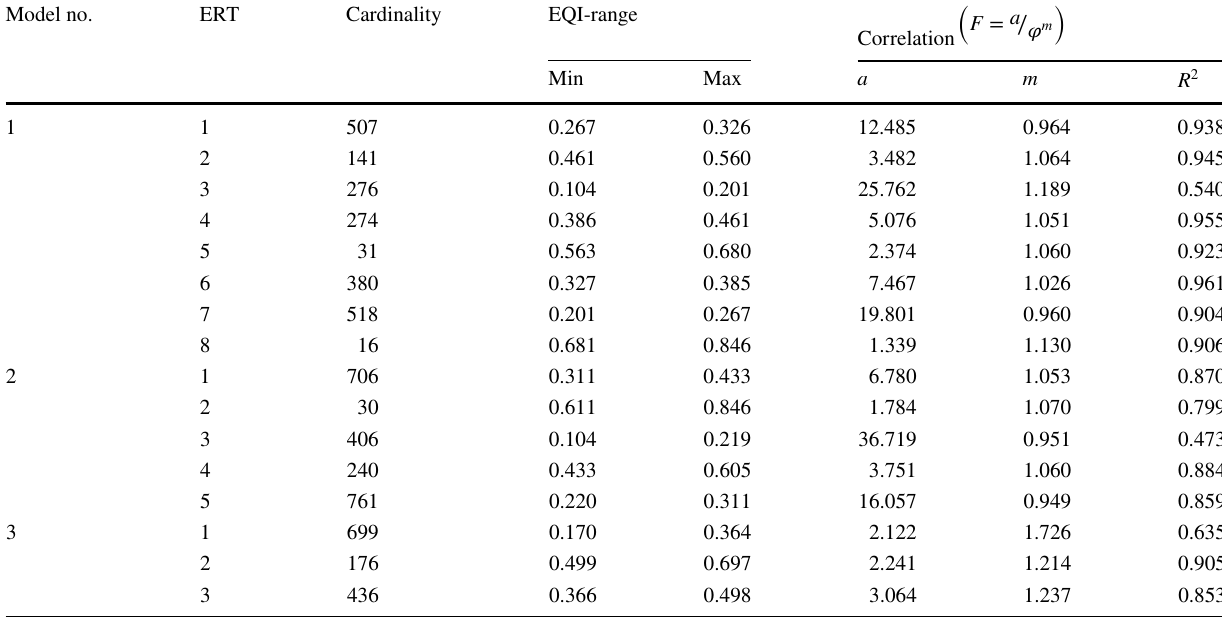
Table 4 Results of EQI technique for different ERTs (Models 1 and 2: AIC and BIC for carbonates, respectively, Models 3: AIC and BIC for sandstones) Model